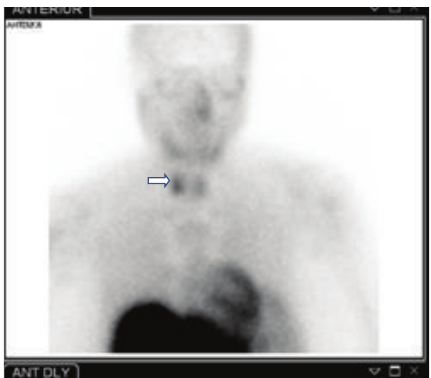
Figure 5: Perioperative PTH monitoring, IOPTH (intraoperative PTH), POPTH (postoperative PTH), and Pg/mL (picograms/mil- liliter).